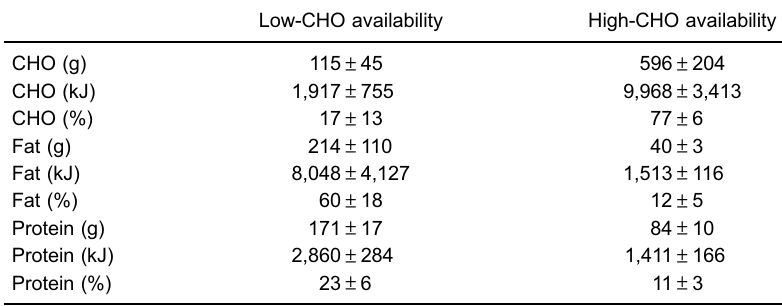
Table 1. Macronutrients intake during the low- and high-(CHO)